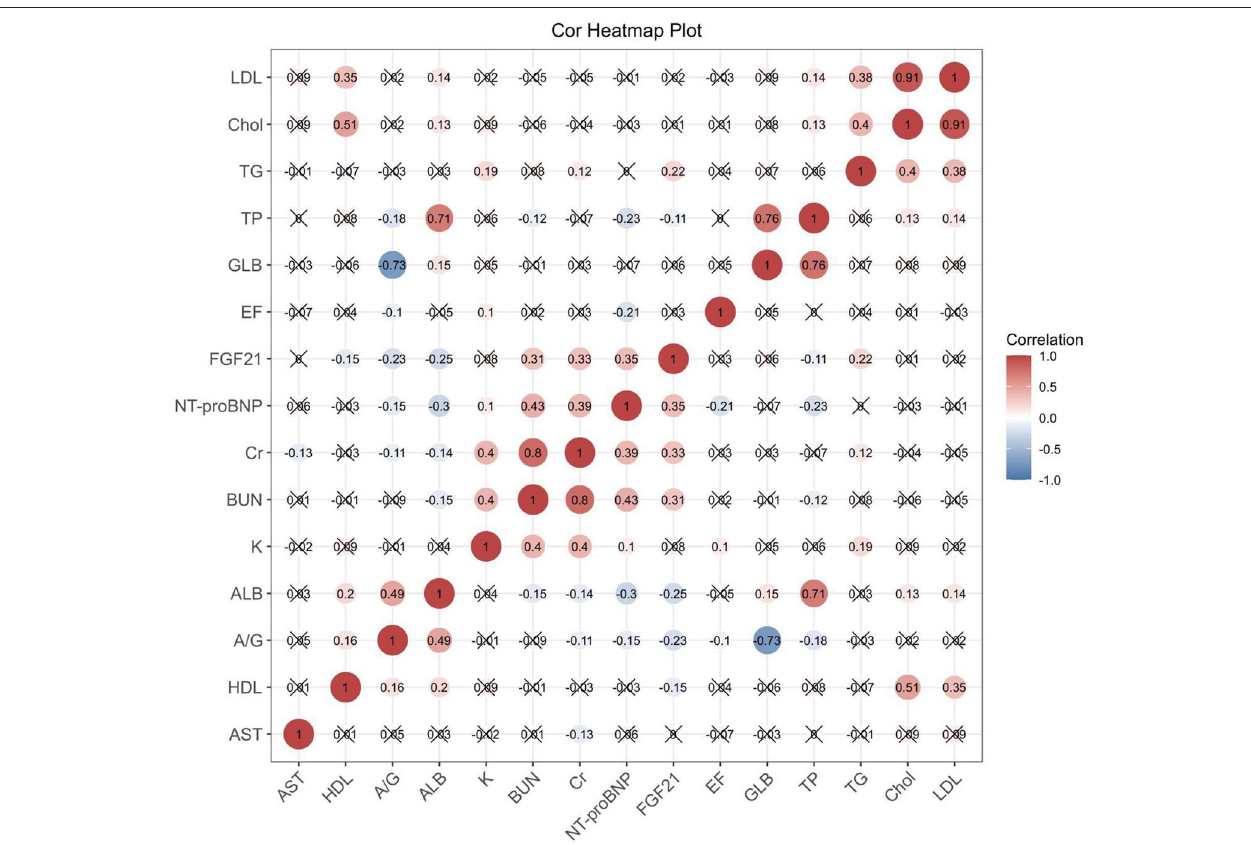
triglyceride levels, suggesting that FGF21 may be a potential biomarker of non-alcoholic fatty liver disease and be involved in the regulation of triglycerides (23). In vitro , many studies